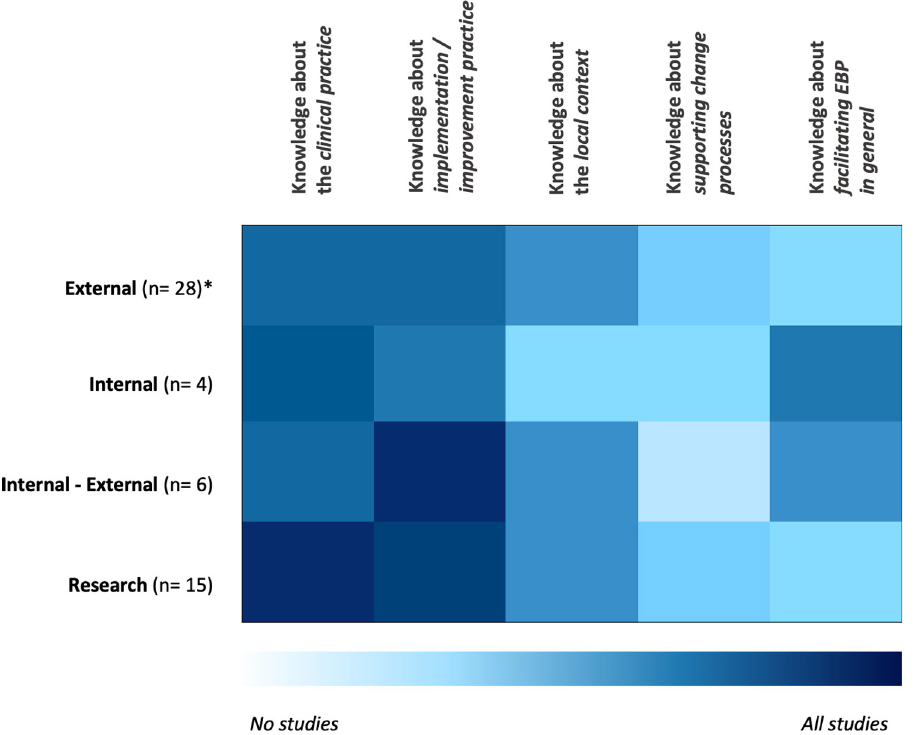
Fig 3. The five most present types of knowledge of ISPs in the included articles according to distinct position. � n = number of reported studies; positions were included with a minimum of n = 4 reported studies.